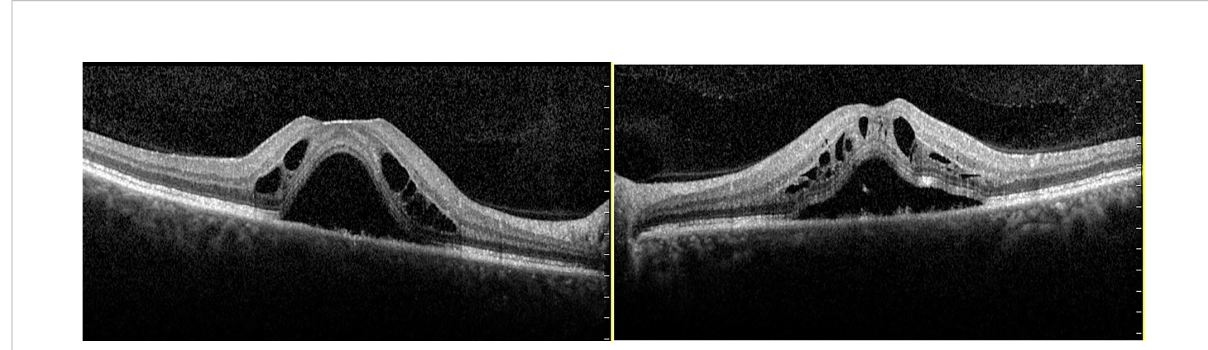
FIGURE 1 Optical coherence tomography scans of both eyes of a 54-year-old female patient who presented with decreased visual acuity in both eyes: (left) the right eye; (right) the left eye. Optical coherence tomography showed macular schisis and extramacular intraretinal separation. Alterations of the external limiting membrane, ellipsoid zone, and interdigitation zone were also found in both